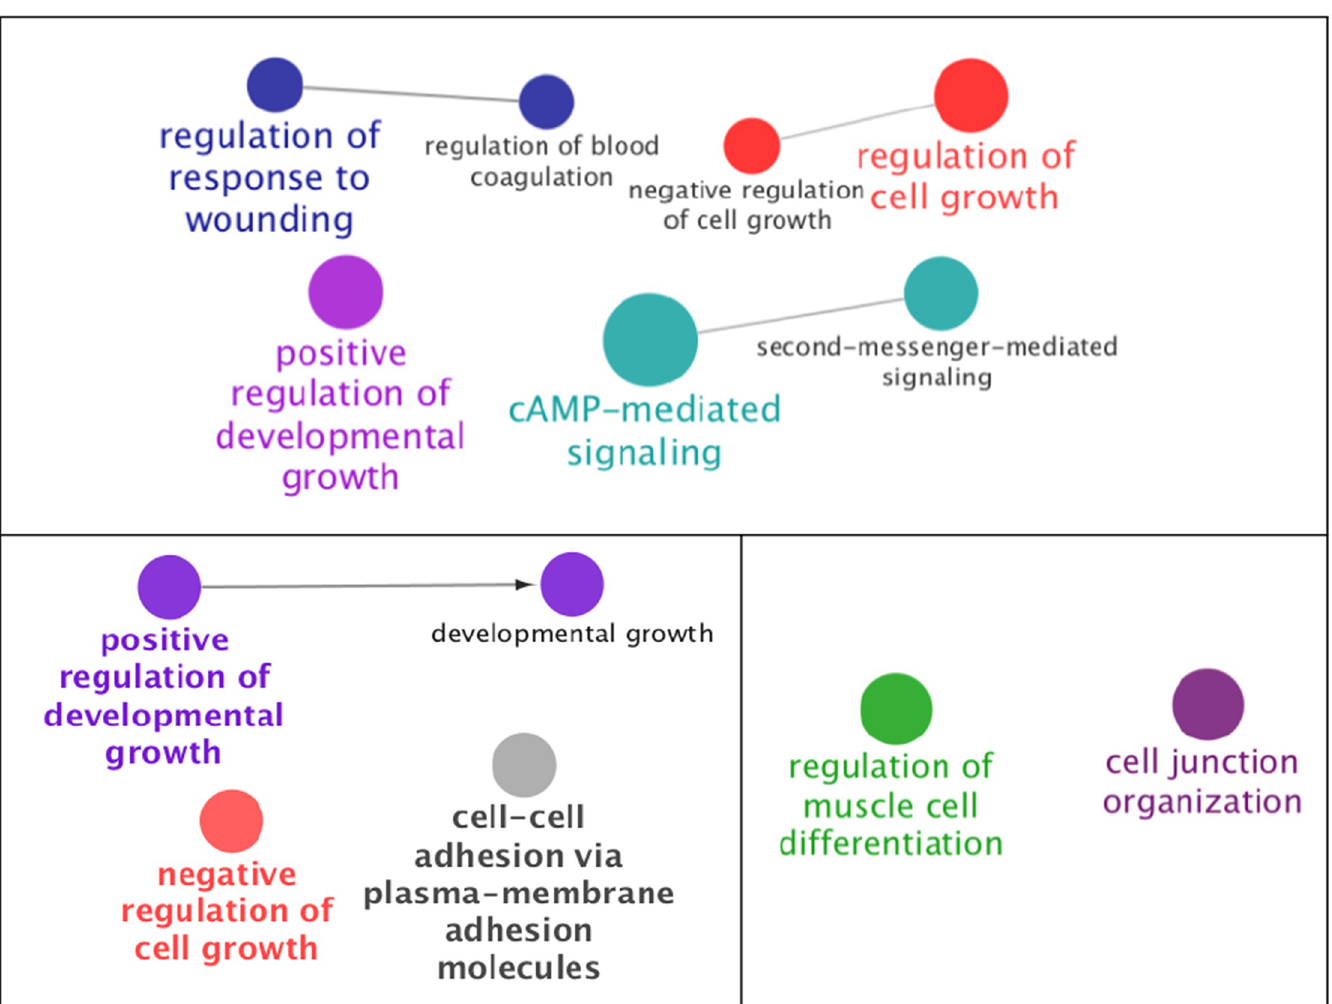
Fig 4. The biological processes that are significantly enriched from the 188 genes that were prioritized by preconditioned random forest regression (top), least absolute shrinkage and selection operator (bottom left), and univariate association strength (bottom right). The label in bold indicates the biological process with the lowest enrichment p-value in the group that it belongs to. The processes with lower p-values were drawn with larger node sizes. Undirected lines indicate empirical associations based on kappa index whereas the connecting line with an arrow indicates previously known relationships between GO terms. The distances between the nodes were set for visualization purposes. A list of genes associated with each process is shown in S2